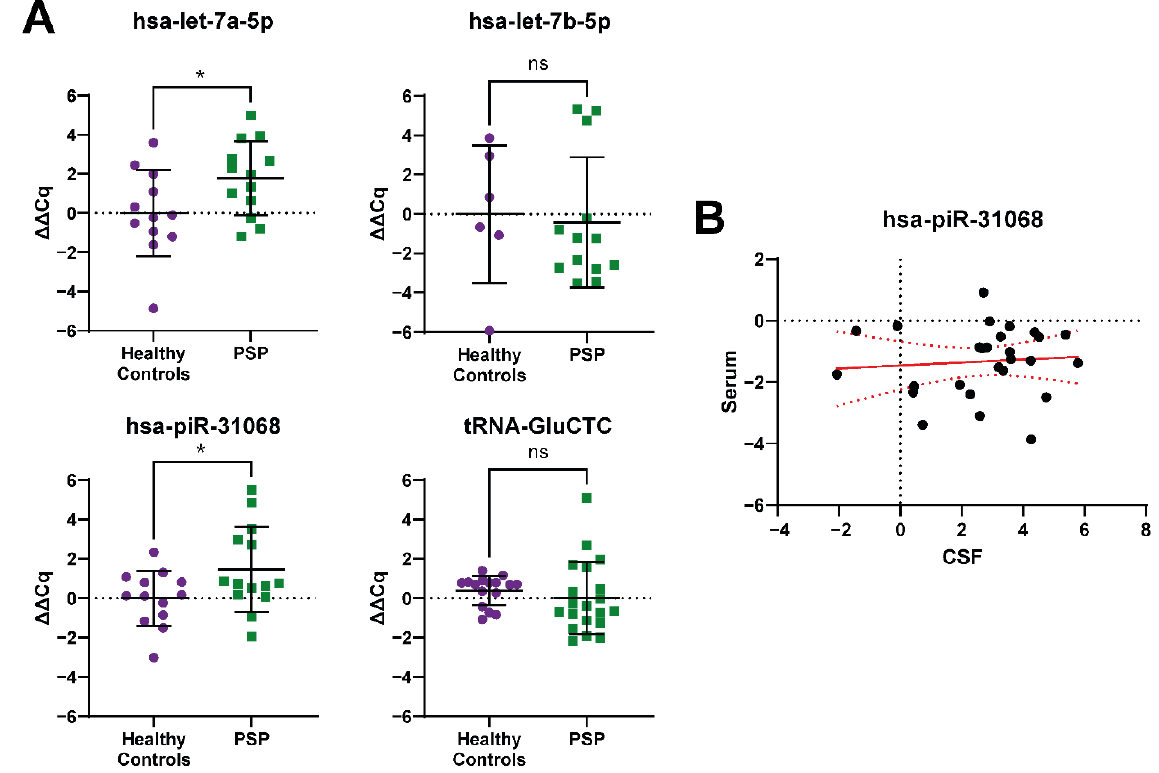
Figure 3. RT-qPCR profiling of ncRNA biomarker candidates in CSF from RNA-seq data in PSP samples. ( A ) Two of the four ncRNA transcripts that showed normal amplification during RT-qPCR across a majority of samples showed significant dysregulation in the PSP samples compared to the average of the healthy control samples. ( B ) No significant correlation exists between the expression of hsa-piR-30168 between serum and CSF within the same PSP patients. Relative expression (control minus PSP) ± SD; normalised to hsa-miR-155-5p; hsa-let-7b-5p, tRNA-GluCTC: Mann–Whitney test; hsa-let-7a-5p: Welch’s test; hsa-piR-31068: unpaired t -test; * p < 0.05; correlation: Bayesian correlation, ns = not